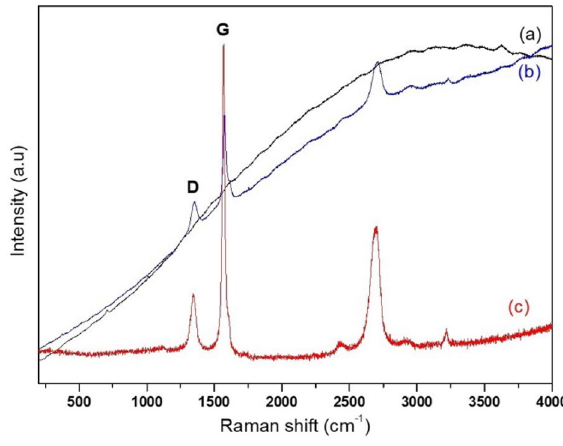
Figure 3. Raman spectra: ( a ) MMt; ( b ) GO; and ( c )